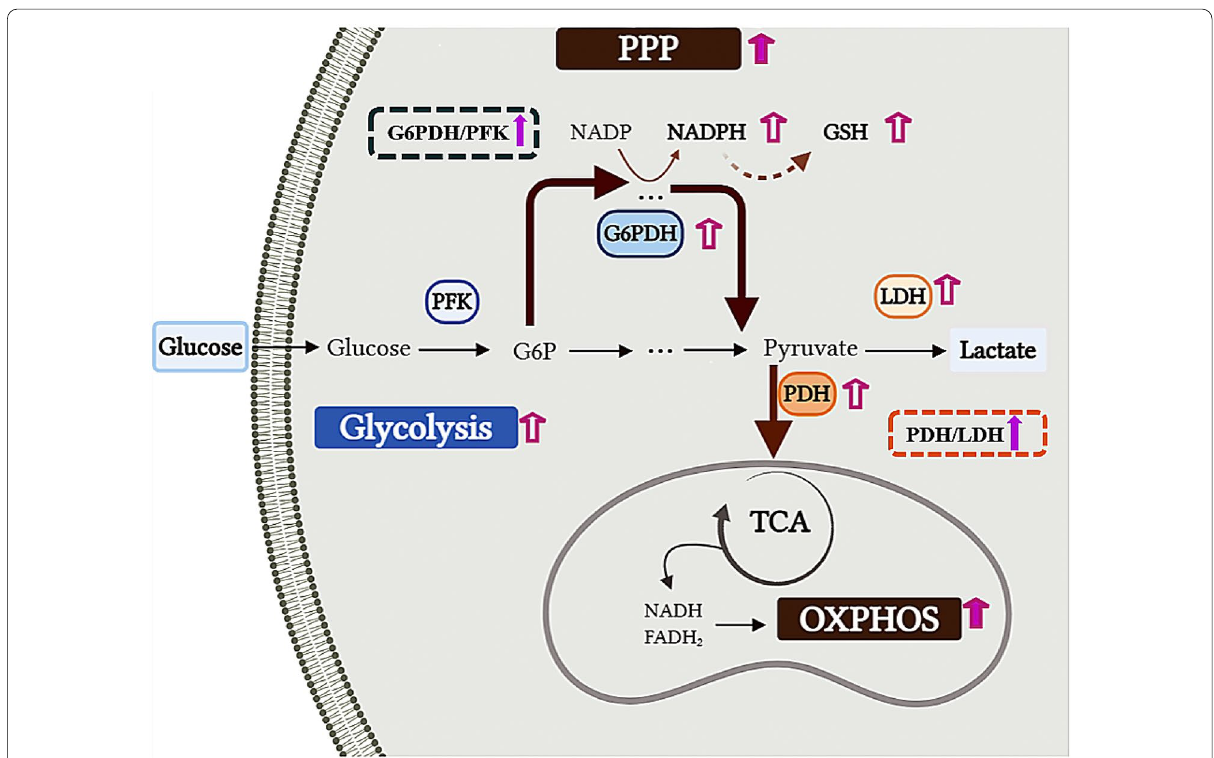
Fig. 6 Overview of glucose metabolism distribution in EM‑V4‑cultured NK92 cells. Upregulated metabolic pathways, enzyme activities and intracellular metabolites are indicated with red